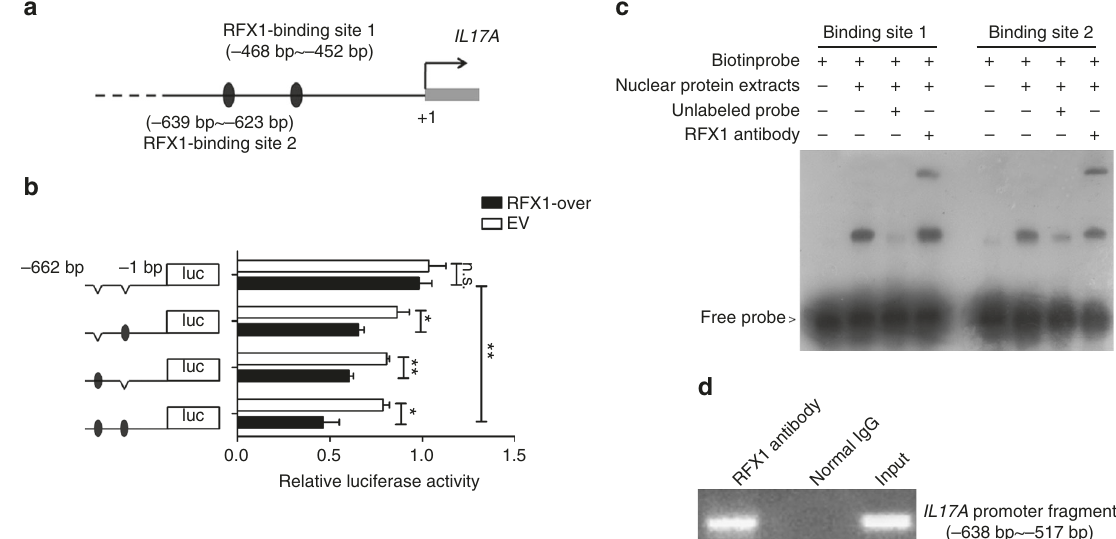
Fig. 3 RFX1 regulates IL-17A expression through binding to the IL17A promoter. a The two predicted binding sites of RFX1 in the IL17A promoter. Site 1 is located at ~468 – 452 bp, and Site 2 is located at ~639 – 623 bp, both upstream of the TSS of IL17A . b Luciferase reporter vectors with or without binding Site 1 and/or Site 2 are shown to the left. Jurkat cells were transfected with the reporter plasmids and either pcDNA3 empty vector (white bars) or RFX1 expression plasmid (black bars). Cells were lysed 48 h after transfection, and fi re fl y luciferase activity was measured and normalized to Renilla luciferase activity. Each experiment was performed in Jurkat cells in triplicate ( n = 3), and values are given as the mean ± s.d. * P < 0.05; ** P < 0.01; n.s., not signi fi cant, compared between the indicated groups. P -values were determined using two-tailed Student ’ s t -tests. c EMSA was used to detect the binding of RFX1 protein with binding Site 1 and Site 2 in the IL17A promoter in vitro. The biotin probe speci fi c for Site 1 or Site 2 was bound by nuclear protein extracts of CD4 + T cells, which could be blocked by an RFX1 antibody. d ChIP assay was used to analyze the in vivo relevance of RFX1 binding to the IL17A promoter. Gel electrophoresis bands indicated the binding of RFX1 in the promoter region of IL17A . Three independent experiments were repeated in c , d